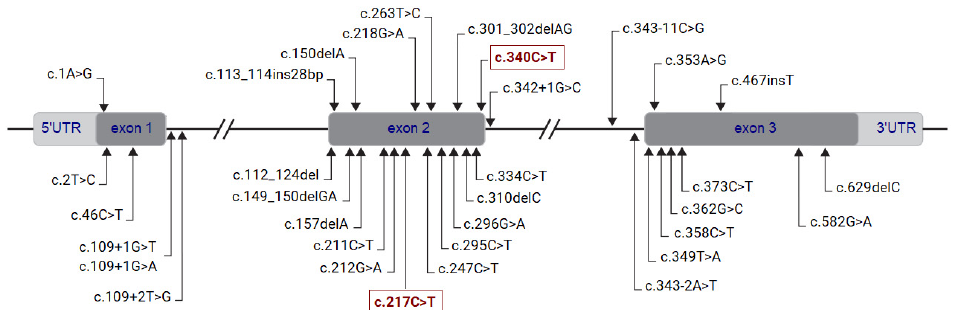
Figure 3. Mutation analysis of the ProP1 gene in sporadic case. ( A ) Pedigree of the S1 sporadic case. ( B ) Electropherogram analysis of ProP1 gene in the family. The c.340C>T mutation in exon 2 resulted in truncated protein lacking the last 112 codons [p.(Gln114Ter)]. Mutated nucleotide on the chromatographs is in bold, underlined and depicted with an arrow. Amino acid substitution is indicated in red.